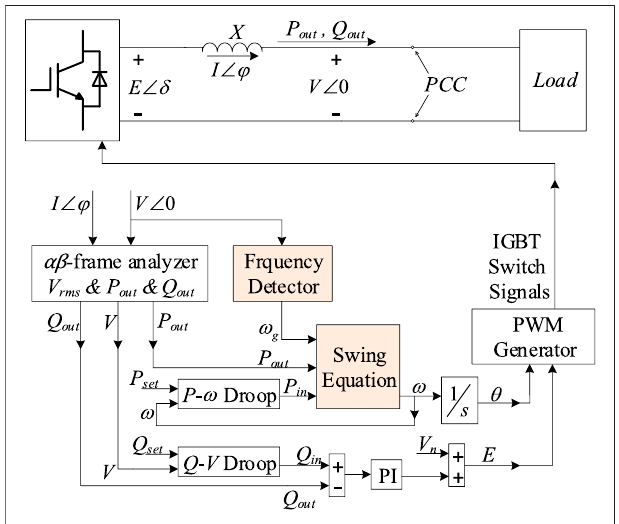
FIGURE 1 | Single VSG connected to in fi nite